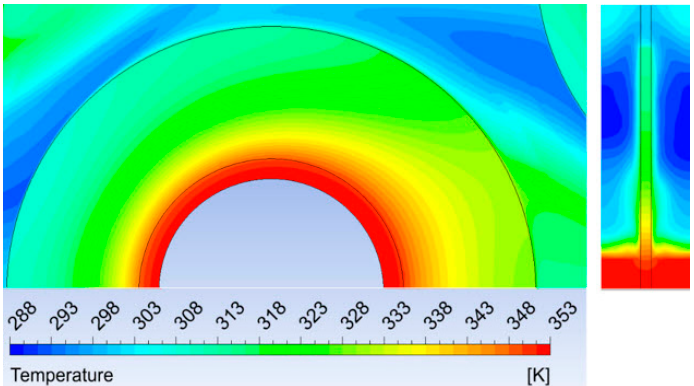
Figure 11. Temperature contours over fins in the 3rd row for air velocity 5 m/s. Left: Finned tube cross section, Right: Fin cross ‐ section.